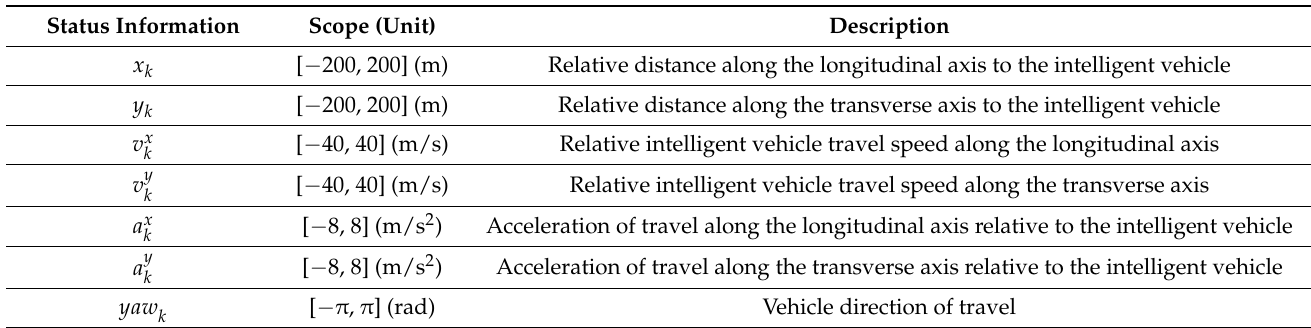
Table 1. Definition of vehicle status information. Table 1. De fi nition of vehicle status information. Table 1. De fi nition of vehicle status information.